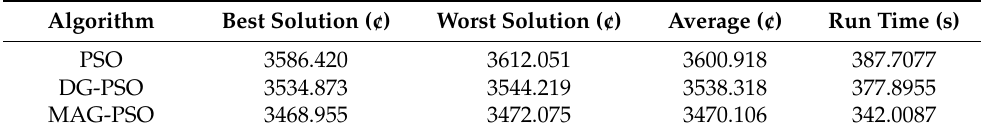
Table 5. Results of the best, worst, and average solutions.